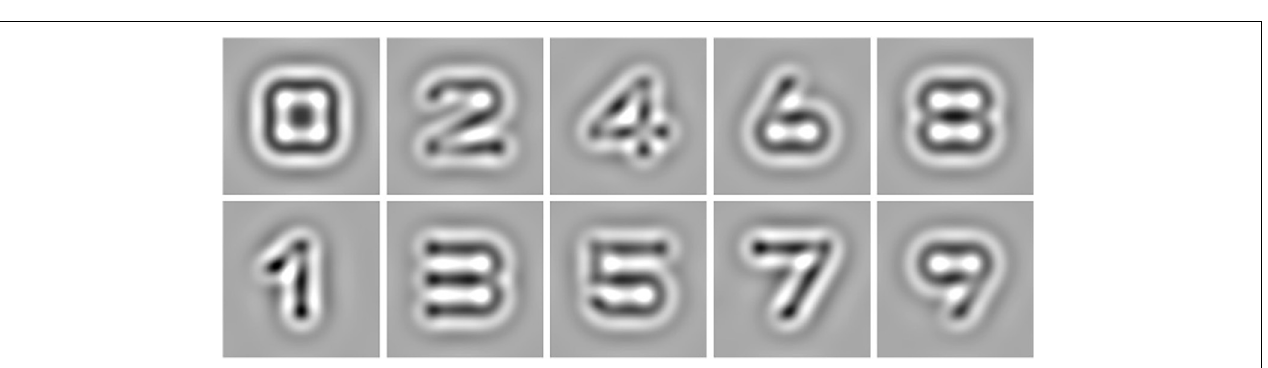
FIGURE 1 | Optical coherence tomography angiography (OCTA) image analysis. (A) A fundus image, with the macula divided into three subfields: the fovea (1 mm), parafovea (1–3 mm), and the perifovea (3–6 mm). (B) OCTA image of the retinal superficial vascular density (SVD). (C) OCTA image of the retinal deep vascular density (DVD). (D) OCTA image of the inner retinal thickness (IRT). (E) OCTA image of the outer retinal thickness (ORT). (F) OCTA image of the choroidal thickness (ChT) in macular.